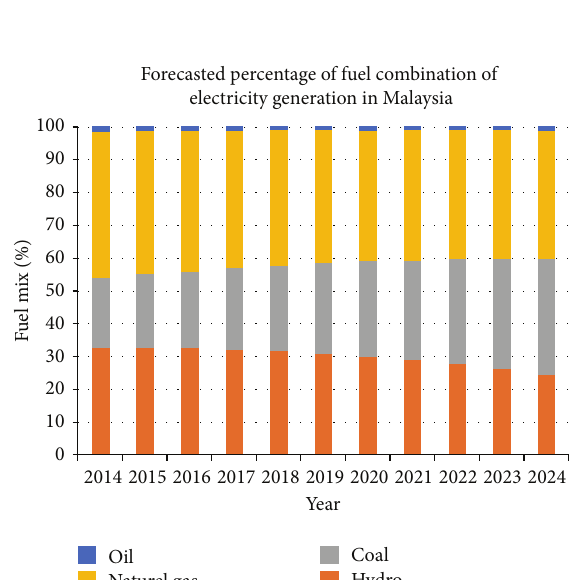
Figure 6: Forecasted percentage of fuel combination of electricity generation in